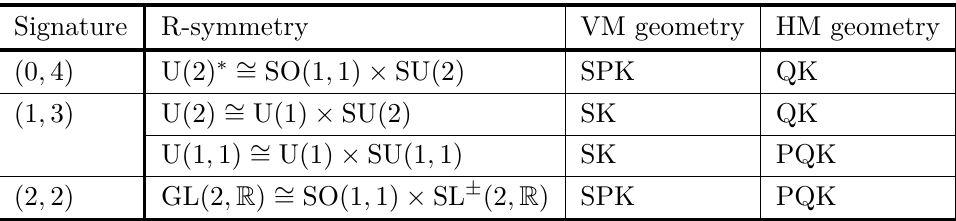
Table 13. Four-dimensional N = 2 supersymmetry algebras, their R-symmetry groups and the scalar geometries of vector multiplets (VM) and hypermultiplets (HM). SK = special Kähler, SPK